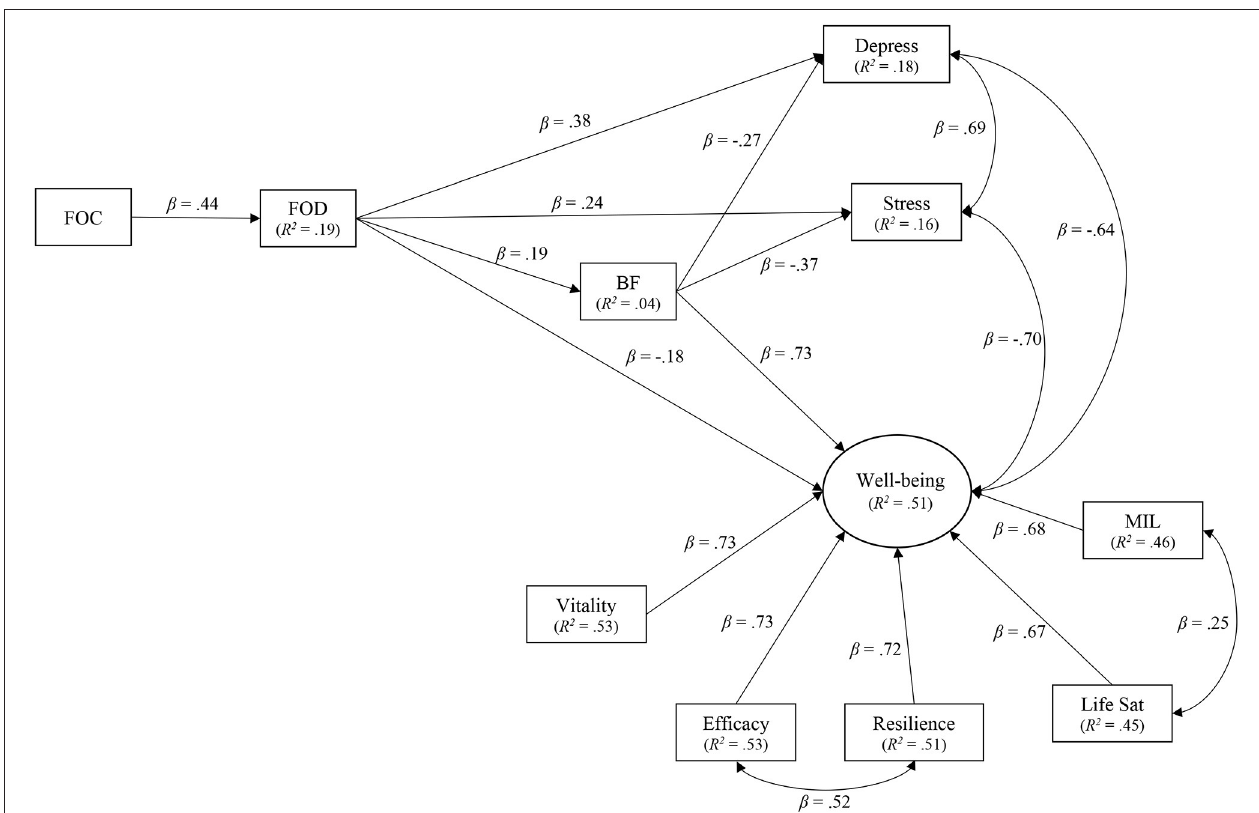
FIGURE 1 | Final model. All paths (solid lines) shown are significant at p ≤ 0.010. FOC, fear of COVID-19; FOD, fear of death; BF, benefit finding; MIL, meaning in life.